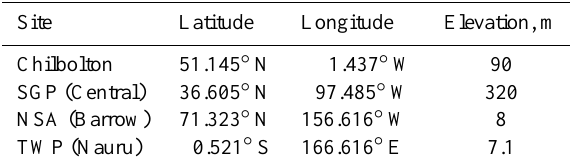
Table 3. Locations and elevation above mean sea level of stations providing ground-based CTH data used in this work.